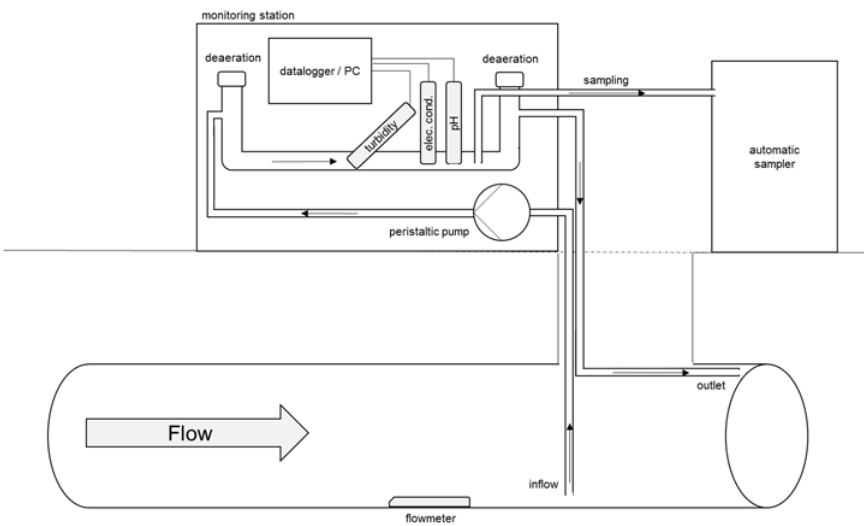
Figure 1. Schematic overview of the monitoring station.